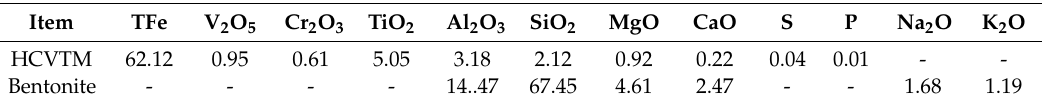
Table 1. Chemical composition of high chromium vanadium-titanium magnetite (HCVTM) and bentonite (wt